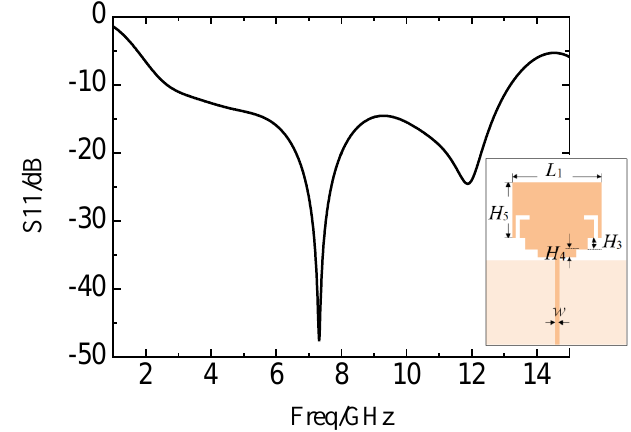
Figure 6. Simulation results of the reflection coefficient curve after loading two L-shaped slots on the microstrip patch.